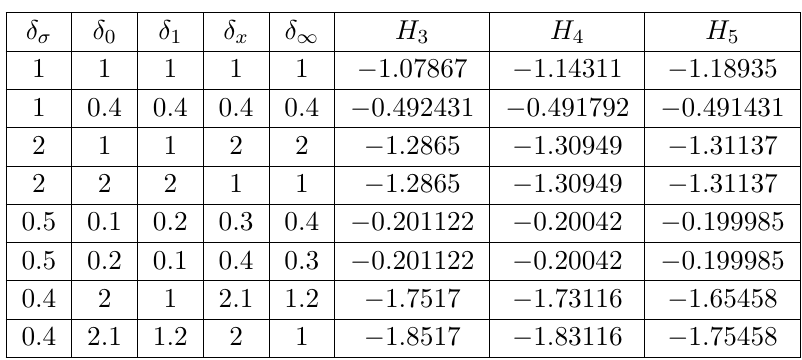
Table 1 . Numerical coefficients from order x 3 to order x 5 for different values of (cid:14) ’s. Open